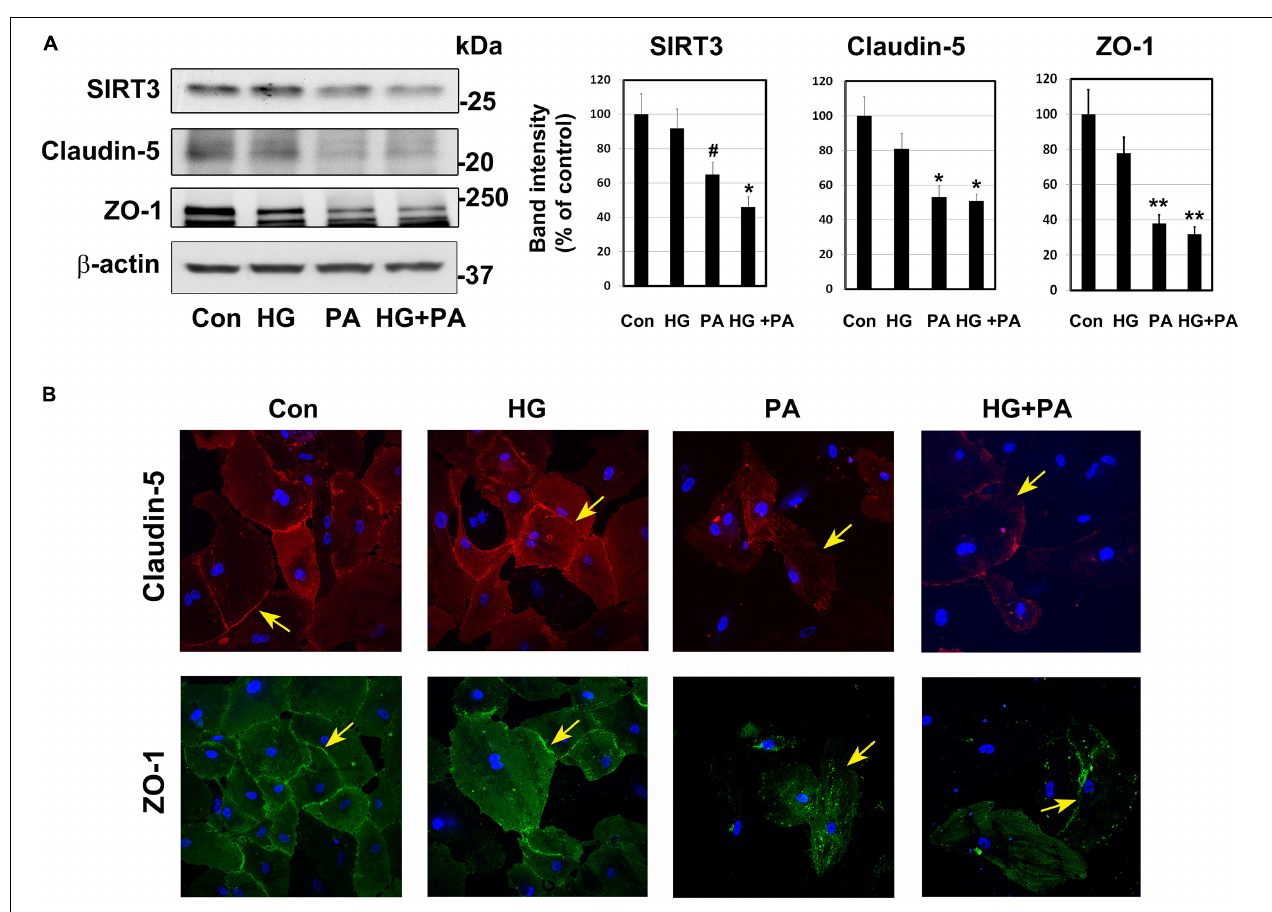
FIGURE 3 | Glucolipotoxicity-mediated BMEC injury. (A) BEND3 cells, a mouse brain endothelial cell line, were exposed to HG, PA or the combination of both for 48 h and processed for the immunoblotting of SIRT3, claudin-5 and ZO-1. The blots were re-probed for β -actin. The bands were scanned and corrected for the levels of β -actin. # , P < 0.05; *, P < 0.01; **, P < 0.001 compared to untreated controls. (B) BMECs isolated from human fetal brain (Neuromics) were cultured in the presence of HG, PA or combination of both for 24 h. The cells were fixed and immunostained for claudin-5 with Alexa flour 594 (red; upper panel) or for ZO-1 with Alexa flour 488 (green; lower panel). The nuclei were stained blue with DAPI. Images of stained cells were captured with the Leica SP8 confocal microscope with white laser, using a Leica HC PL APO 40 × 1.30 NA oil objective. HG, high glucose (30 mM); PA, palmitic acid (300 µ